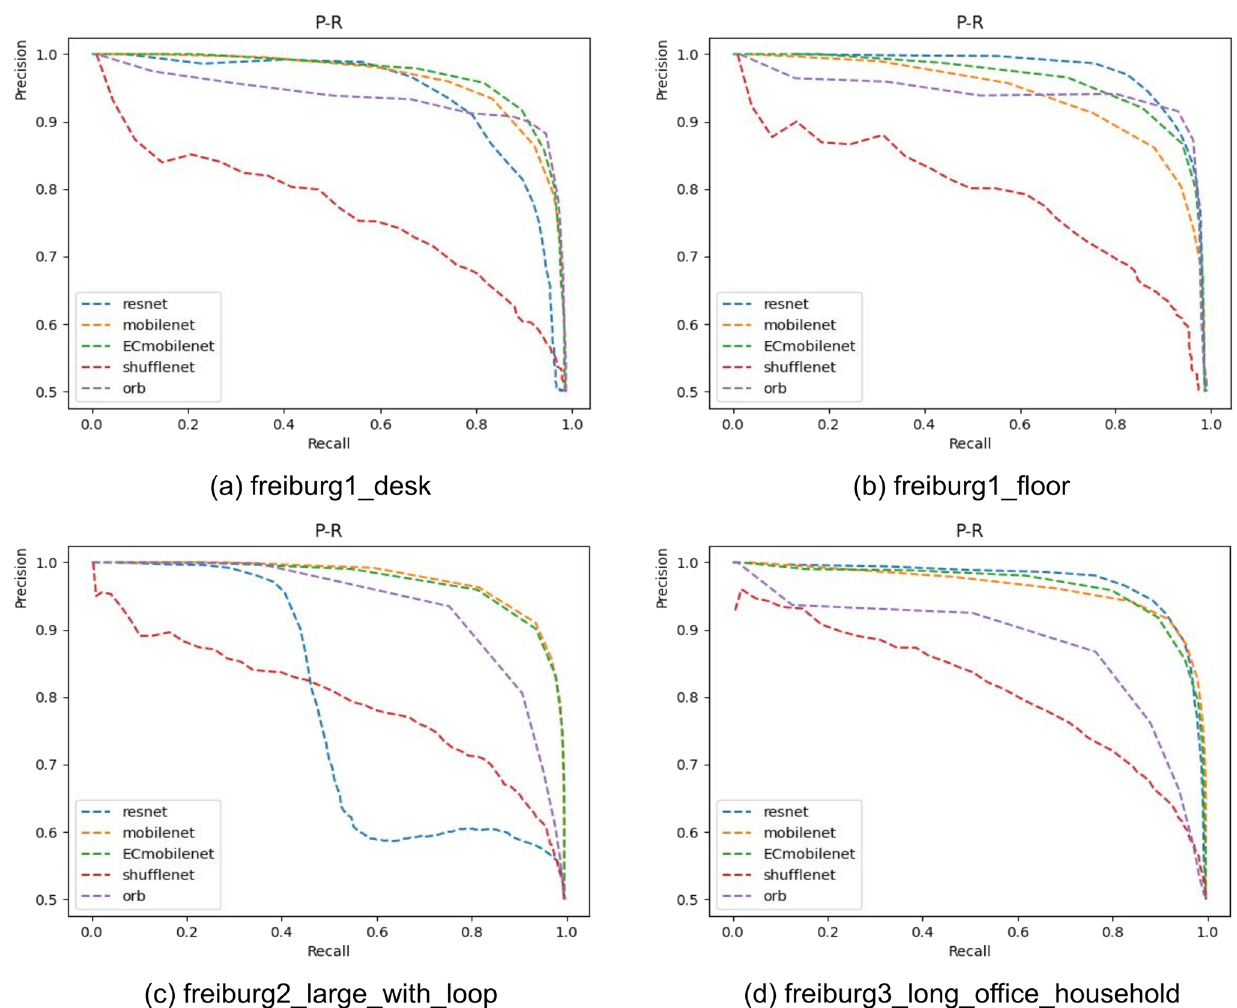
Fig. 10 P–R curve about TUM